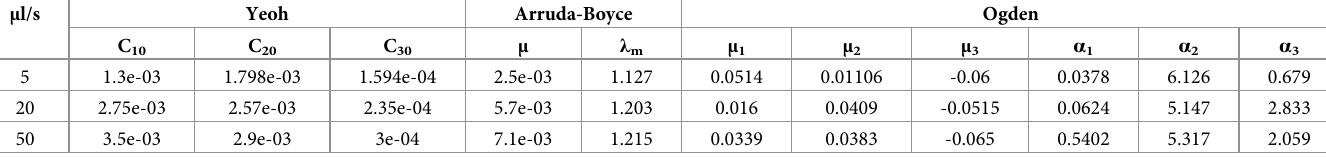
Table 1. Material parameters obtained after calibrating the SEFs model to experimental data (C i and μ i are in MPa). μ